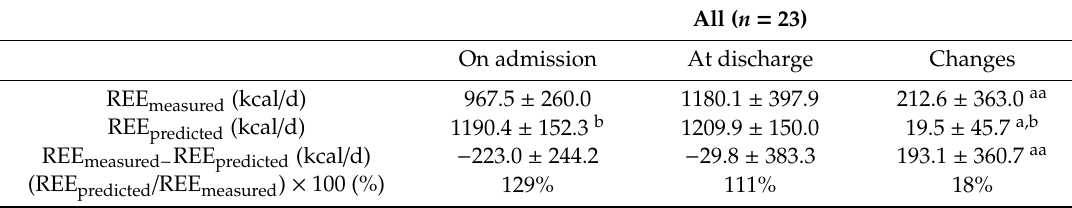
Table 2. Measured and predicted REE on admission and at